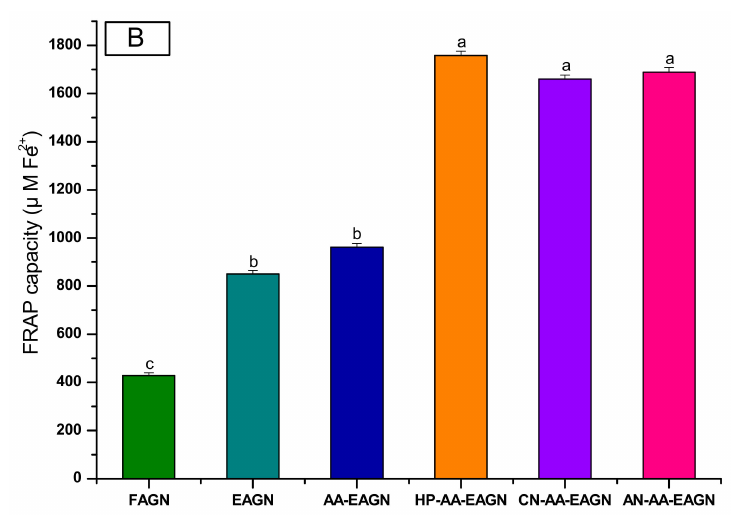
Figure 7. The antioxidant capacity of the AGNC. DPPH ( A ) and FRAP ( B ). Values marked by di ff erent letters in each column are significantly di ff erent in the t -test ( p <